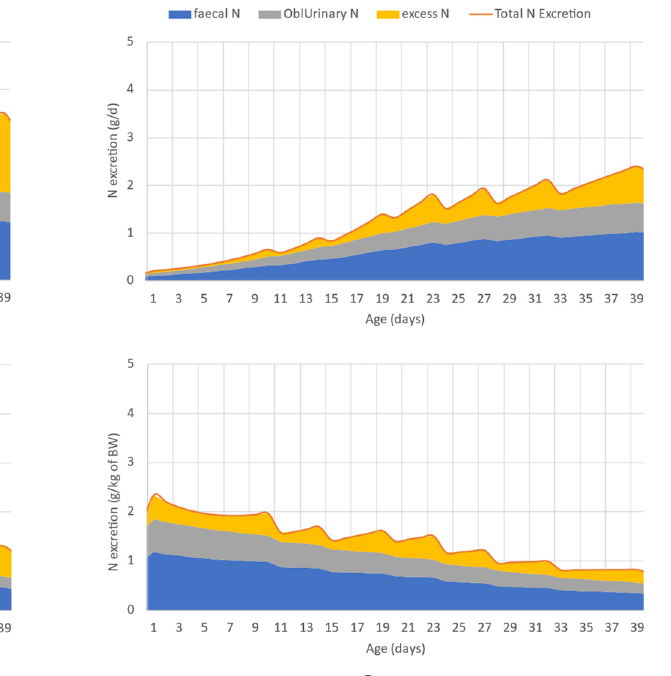
Figure 4. Case study 1. Effect of different feeding schedules ( Sc1 —recommendation of Aviagen; Sc2 —3-phase feeding adjusted to the simulated protein and AA requirement; Sc3 —7-phase feeding schedule with more gradual decrease in dietary protein levels) on total N excretion (orange line) and its partitioning between urinary (obligatory N excretion—grey area and excess N—yellow area) and faecal N excretion (blue area), in grams per day (upper panel) and grams per kg of live weight (down panel).